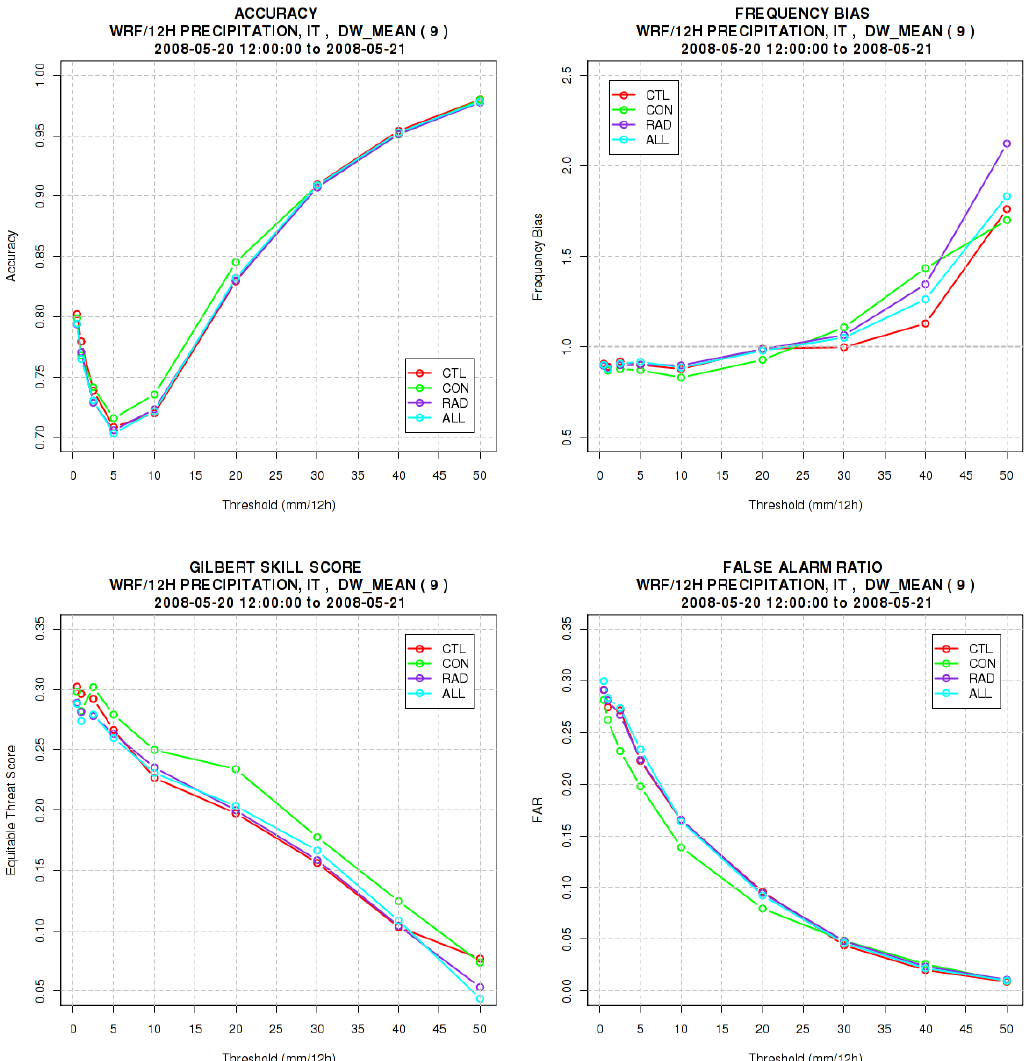
Figure 11. ACC (top left), FBIAS (top right), ETS (bottom left) and FAR (bottom right) as a function of threshold. The red line shows CTL, the green line CON, the violet line RAD, and the cyan line